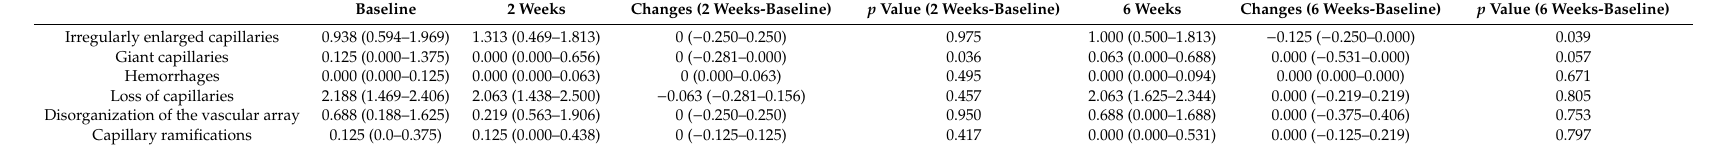
Table 5. Changes of nailfold capillary microscopic findings (2 weeks, 6 weeks).